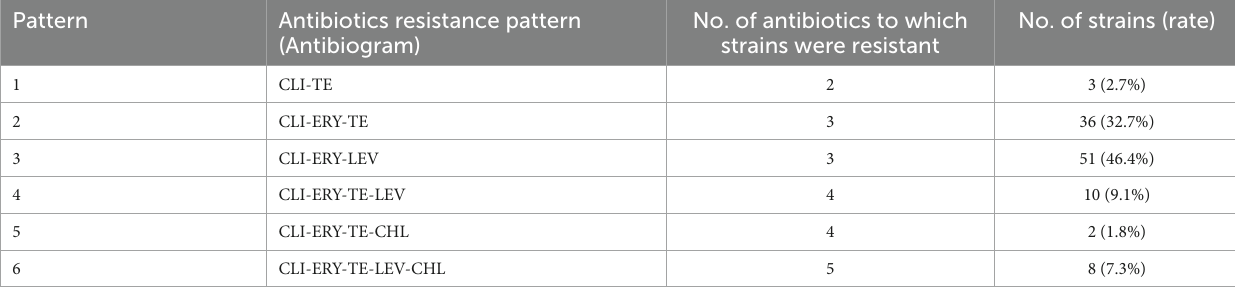
CLI, clindamycin; ERY, erythromycin; LEV, levofloxacin; TE, tetracycline; CHL,